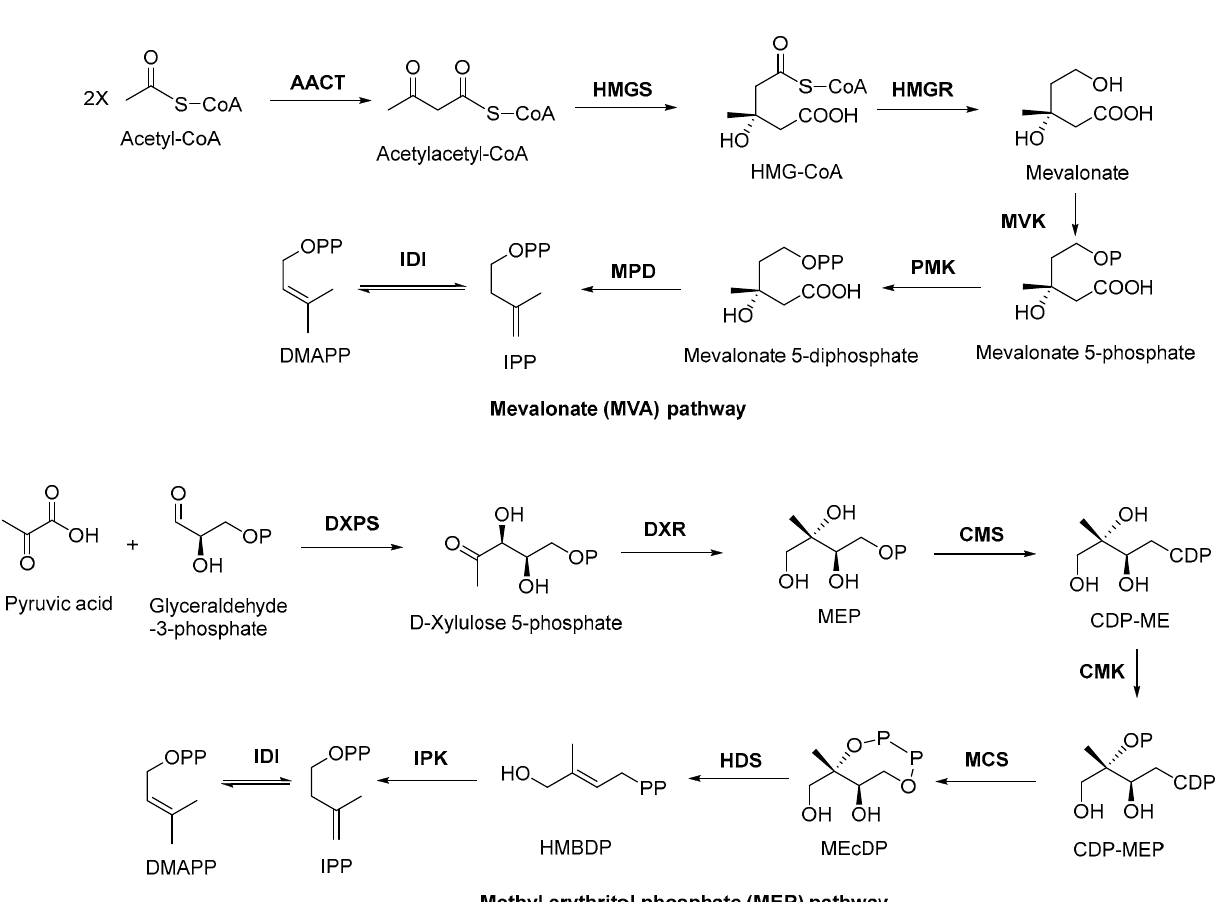
Figure 1. MVA and MEP pathways involved in terpenoid biosynthesis. AACT, acetoacetyl coen- zyme A thiolase; HMGS, 3-hydroxy-3-methyl glutaryl coenzyme A synthetase; HMGR, 3-hydroxy- 3-methyl glutaryl coenzyme A reductase; MVK, mevalonate kinase; PMK, phosphomevalonate ki- nase; MPD, mevalonate-5-pyrophosphate decarboxylase; IDI, isopentenyl diphosphate isomerase; DXPS, 1-deoxy-xylose-5-phosphate synthase; DXR, 1-deoxy-xylose-5-phosphate racemic enzyme; CMS, 4-diphoxphocyt-idyl-2- C -methyl-2-(E)-butenyl-4-diphosphate synthase; CDP, cytidine-4-diphosphate; CDP-ME, cytidine-4-diphosphate-2- C -methylerythritol; CMK, 4-diphoxphocyt-idyl-2- C -methyl-D-erythritol kinase; CDP-MEP, cytidine-4-diphosphate-2- C -methyl-D-erythritol-2-phosphate; MCS, 2- C -methyl-D-erythritol-2,4-cyclodiphosphats synthase; MEcDP, 2- C -methyl-D-erythritol-2,4-cyclophosphoric acid; HDS, 1-hydroxy-2-methyl-2-(E)-butenyl-4-diphosphate synthase; HMBDP, 1-hydroxy-2-methyl-2-(E)-butenyl-4-diphosphate; IPK, isopentenyl monophosphate ki- nase.